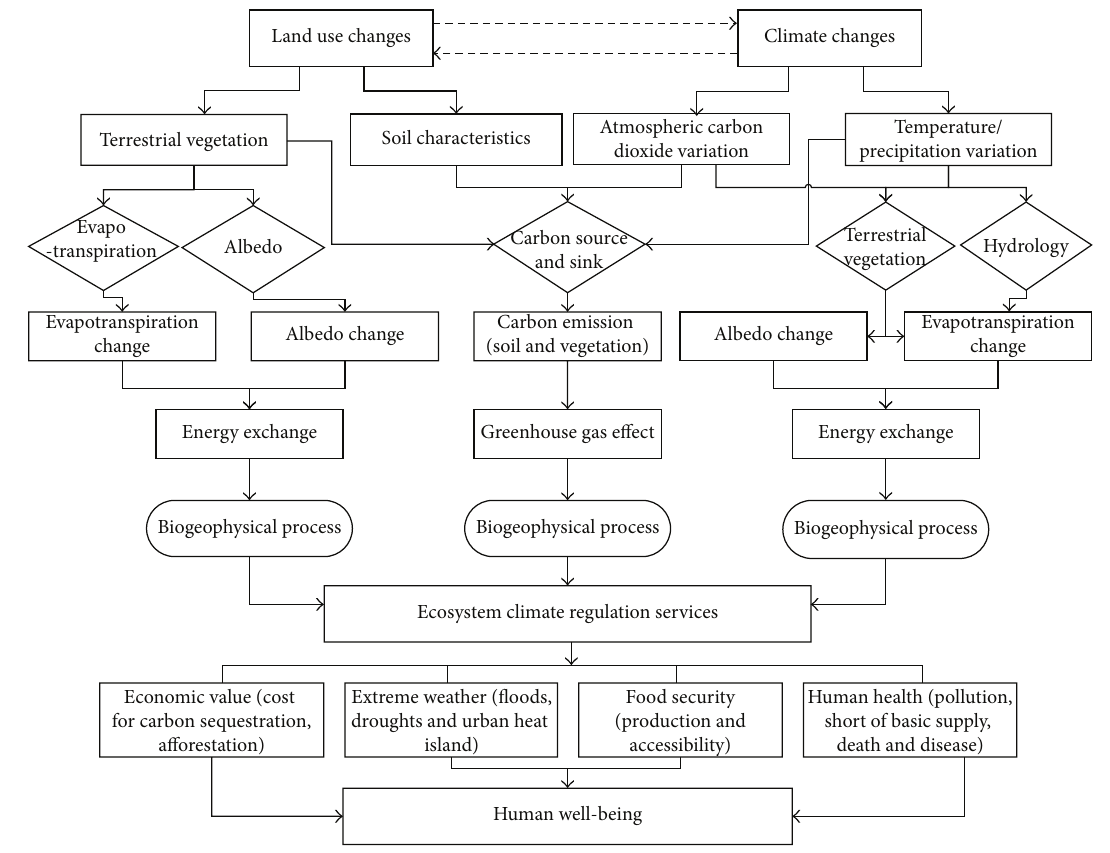
Figure 1: Framework for integrating land-use induced effects on climate regulation services into impact assessment for human